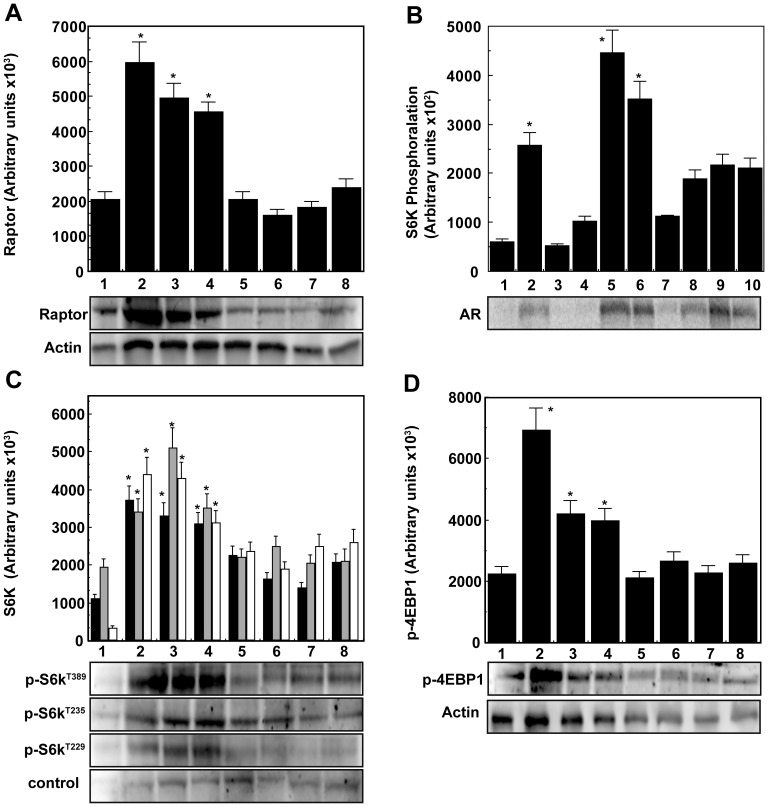
Effect of silencing Raptor expression by RNAi on phosphorylation of S6 kinase and 4EBP1 in 1-LN cells stimulated with α2M* and insulin.Panel A. Bar diagram showing levels of Raptor in cells transfected with Raptor dsRNA and stimulated with α2M* or insulin. The bars are: (1) lipofectamine + buffer; (2) lipofectamine + α2M* (50 pM/25 min); (3) lipofectamine + insulin (200 nM/20 min); (4) scrambled dsRNA (100 nM/48 h) + insulin; (5) Raptor dsRNA (100 nM/48 h); (6) Raptor dsRNA (100 nM/48 h) then α2M*; (7) Raptor dsRNA (100 nM/48 h) then insulin (200 nM/20 min); (8) rapamycin (100 nM/20 min) then insulin. Values are mean ± SE from three to four independent experiments and are expressed as arbitrary fluorescence units. Values significantly different at 5% level for α2M*, insulin and scrambled dsRNA treated cells are indicated by an asterisk (*). A representative immunoblot of Raptor from three to four experiments along with its protein loading control actin is shown below the bar diagram. Panel B. A bar diagram showing mTORC1 activation in cells treated with α2M* and insulin and effect of transfection with Raptor dsRNA on its activation as measured by assaying phosphorylation of S6-Kinase by autoradiography. The bars and lanes in autoradiograph are: (1) lipofectamine + buffer; (2) lipofectamine + α2M* (50 pM/25 min); (3) Raptor dsRNA (100 nM/48 h); (4) Raptor dsRNA + α2M*; (5) lipofectamine + insulin (200 nM/20 min); (6) scrambled dsRNA (100 nM/48 h) + insulin; (7) Raptor dsRNA (100 nM/20 min) then insulin; (8) rapamycin (100 nM/20 min) then α2M*; (9) LY294002 (20 mM/20 min) then insulin; (10) rapamycin (100 nM/20 min) then insulin. A representative autoradiograph of three experiments of S6-Kinase phosphorylation is shown below the bar diagram. Values are the mean ± SE from three experiments and are expressed in arbitrary units. Values significantly different at 5% levels for α2M*, insulin and scrambled dsRNA treated cells are indicated by an asterisk (*). Panel C. A bar diagram showing levels of S6-Kinase phosphorylated at T389 (▪); T229 (see grey square) and T 235/236 (□) in cells stimulated with α2M* or insulin and transfected with Raptor dsRNA. The bars are as in Panel A. Representative immunoblots of p-S6-KinaseT389, p-S6-KinaseT229 and p-S6-KinaseT235/236 of three experiments along with its protein loading control is shown below the bar diagram. Values are the mean ± SE from three experiments and are expressed in arbitrary fluorescence units. Values significantly different at 5% level for α2M*, insulin or scrambled dsRNA are indicated by an asterisk (*). Panel D. A bar diagram showing phosphorylation levels of 4EBP1, in cells treated with α2M* and insulin or transfected with Raptor dsRNA. The bars are as in Panel A. A representative immunoblot of p-4EBP1 of three experiments along with its protein loading control is shown below the bar diagram. Values are the mean ± SE from three experiments and are expressed in arbitrary fluorescence units. Values significantly different at 5% level for α2M*, insulin and scrambled dsRNA-treated cells are indicated by an asterisk (*).